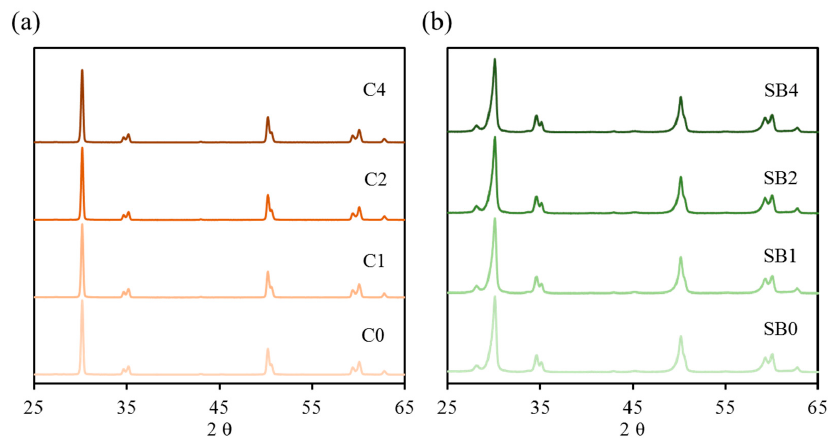
Figure 2. XRD patterns of ( a ) Group C and ( b ) Group SB before and after treatment with di ff erent plasma